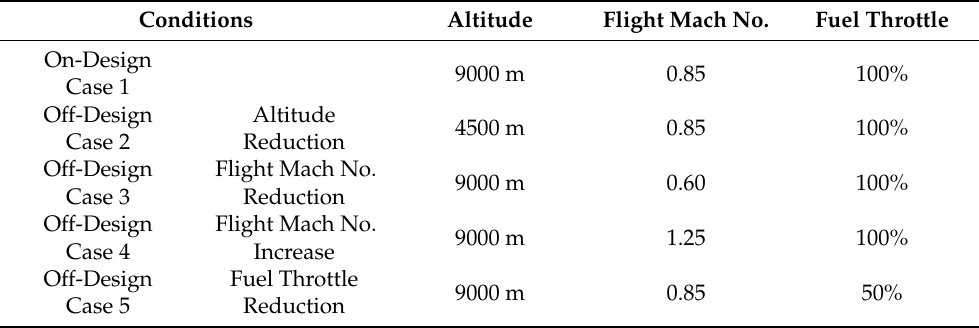
Table 2. Comparative parameter values between the on-design case and the four off-design cases studied.